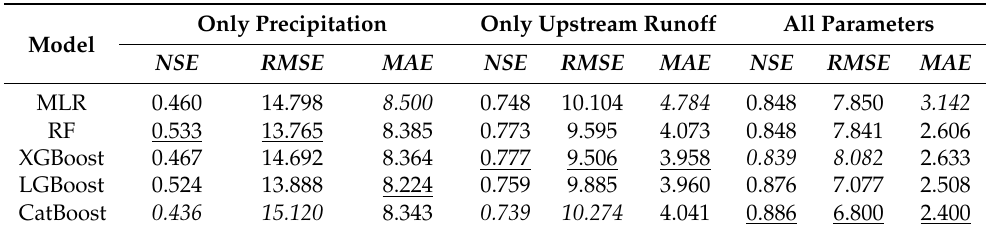
Table 2. Streamflow forecast model performance with default parameters. The best results for each scenario are underlined, the worst are in italic .